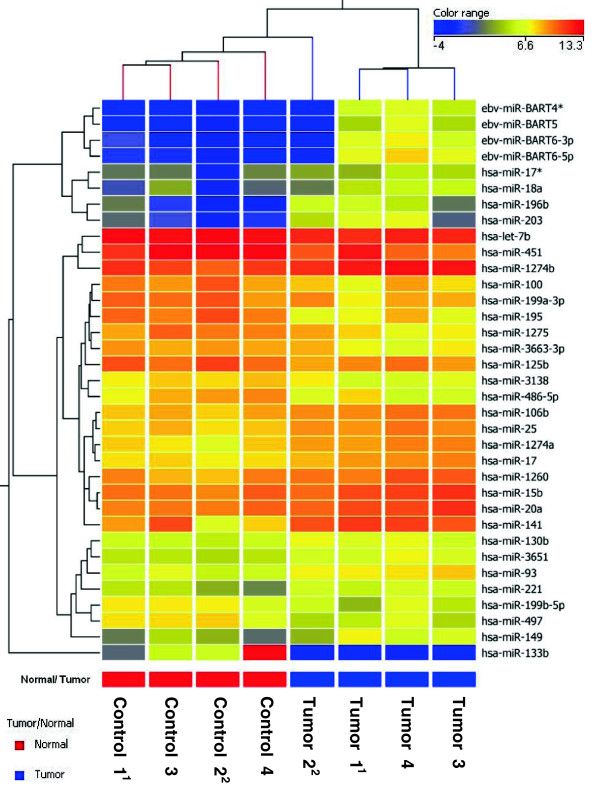
Hierarchical clustering of significantly changed miRNAs in NPC versus normal control tissue. Hierarchy heatmap generated using a Euclidean distance metrics and centroid linkage method. Expression levels of each miRNA in each samples are represented by different colors signifying hybridization intensities. Superscript numbering on sample names denotes those from the same individual (paired NPC/control tissue). Further analysis with statistical information is presented in Additional file 3.